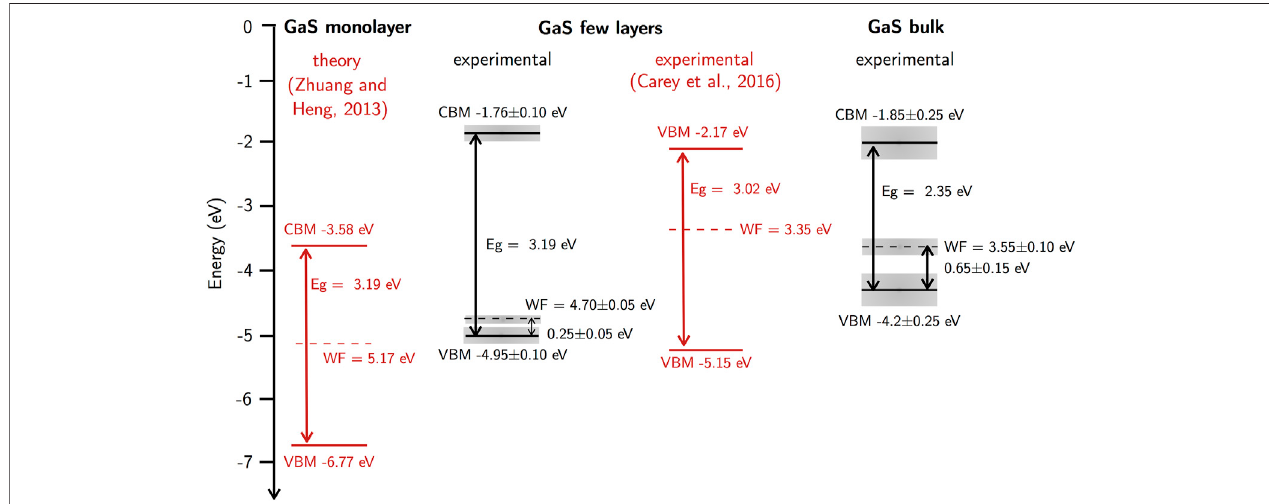
FIGURE 6 | Pro fi ling ofthe valence band maximum (VBM), conduction band minimum (CBM), and Fermi level with respect to the vacuum level for GaSmonolayer, few layers, and bulk considering theoretical (Zhuang and Hennig, 2013; Carey et al., 2017) and experimental values.